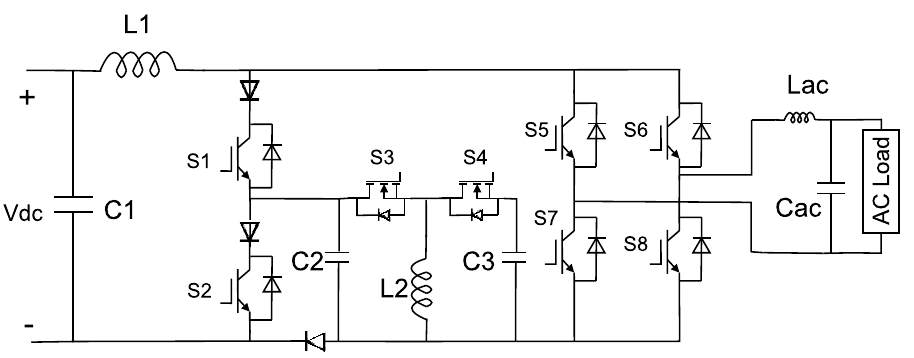
Figure 4. Active power filter for CSIs.